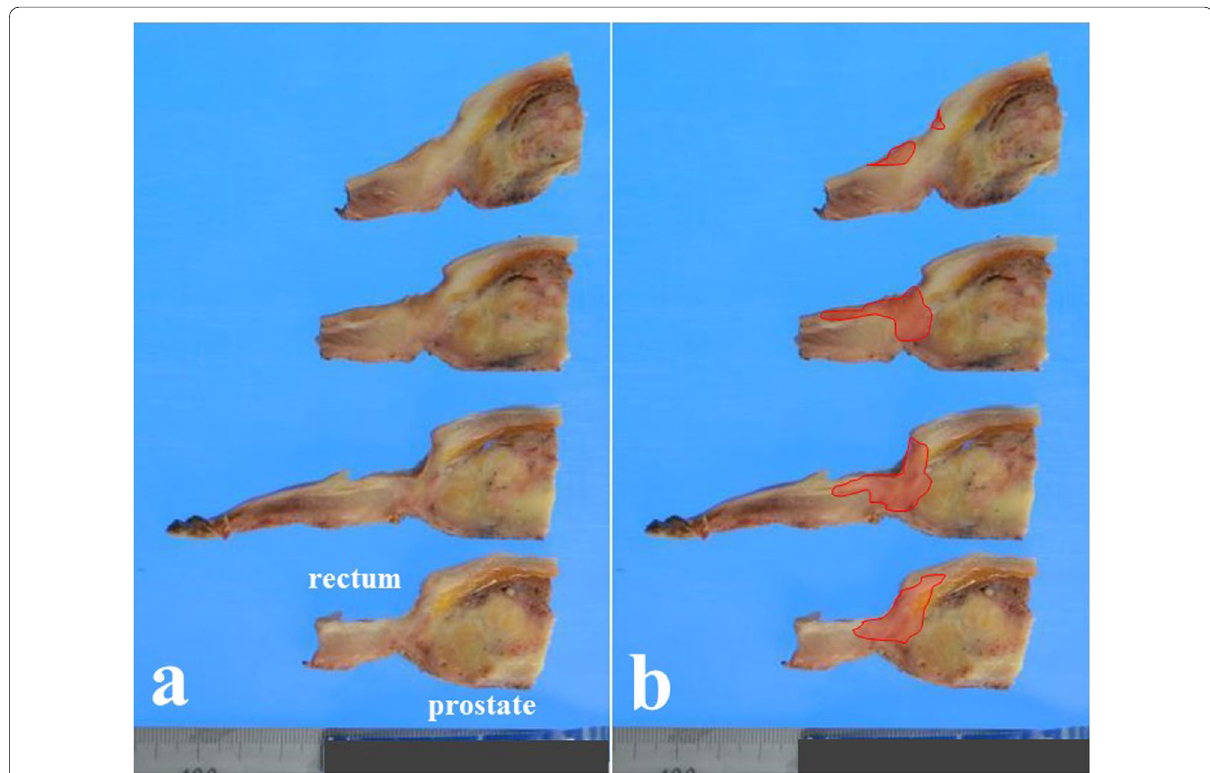
Fig. 3 Slices of the resected specimen fixed in formalin. a Boundary line between the rectum and prostate was unclear because of tumor cell infiltration. b Mapping of viable tumor cells is shown as the area in red. The depth was diagnosed as ypT4b (prostate), and the resection margin was 2.5